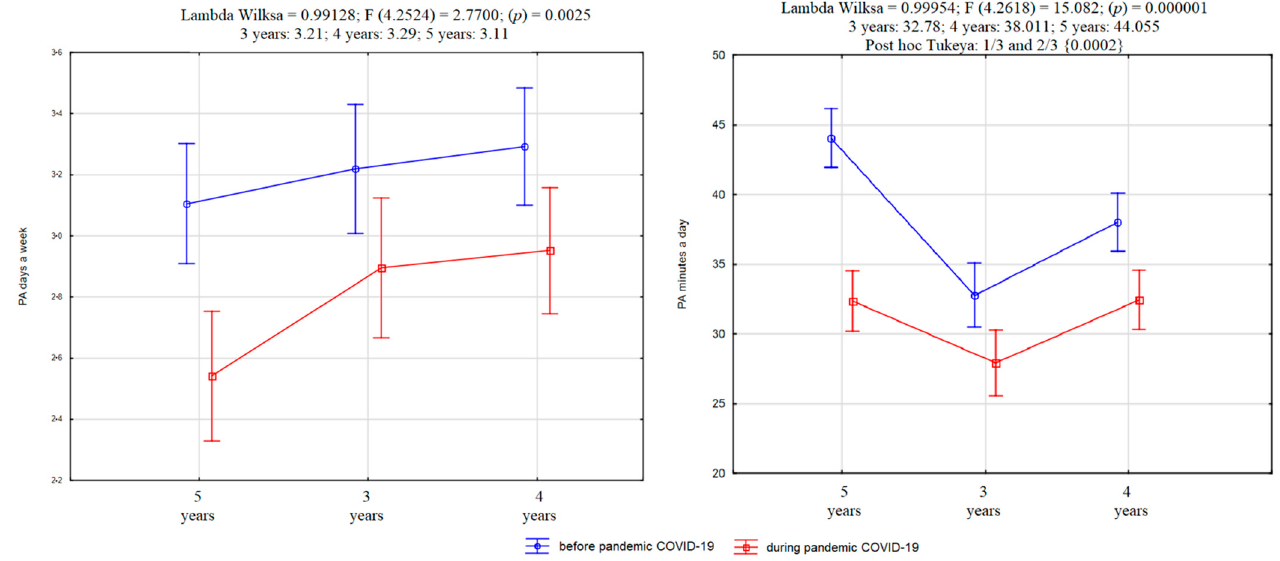
Figure 3. Average values of frequency ( left side ) and time of PA ( right side ) in groups of children aged three to five years. Table 3. Averages, standard deviations, and minimum and maximum values of days and time spent using electronic devices. Type of